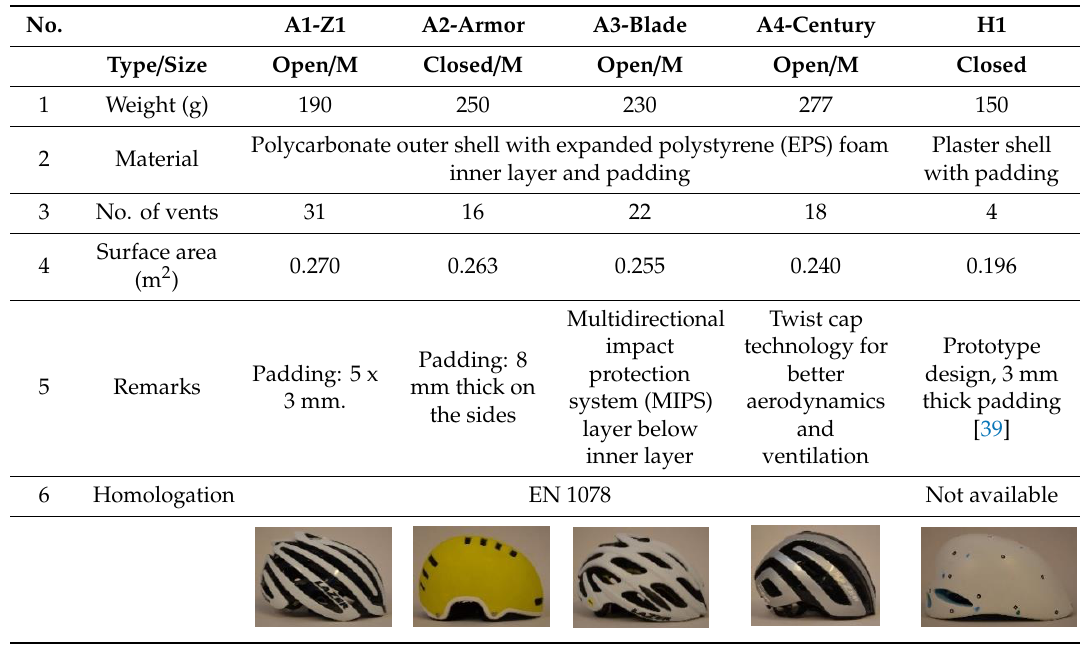
Table 1. Helmets tested in the study and their properties.